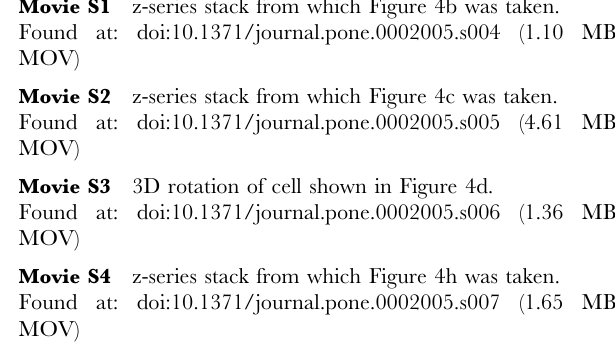
Figure S1 STOP2 confers conditional expression. (a) Epi- fluorescence image of a Pv-cre mouse injected with an AAV vector containing the short Neo-2xpA STOP cassette (LS2L) followed by the human RenillaGFP gene (AAV-LS2L-hrGFP, gift of C. Saper). (b–c) Confocal images of a wildtype control mouse co-injected with AAV-LS2L-hrGFP (b) and a generic AAV-RFP (c), at a 3:1 ratio. (d) Co-localization (white arrowheads) of GFP and parvalbumin (PV) in neocortical basket interneurons in neocortex of a Pv-cre mouse injected with AAV-LS2L-hrGFP; scale bar, 20 microns. Far right, high resolution image of basket cell axons with ‘‘basket-like’’ terminal branches and boutons (yellow arrowheads) around pyramidal cell somata (labeled with NeuN immunofluorescence) characteristic to PV + interneurons; scale bar, 5 microns. Figure S2 Low-level GFP expression in Pv-cre::Z/EG mouse. Epi-fluorescent image of young adult Pv-cre::Z/EG mouse using a 1 sec exposure time (13.3-times longer than that used in Fig. 2a) and a compressed look-up table. Cells (arrowheads) were not visible using the same acquisition parameters as in Fig. 2a. Neither axon nor dendritic branches were readily visible, though occasionally a dendritic branch trunk close to the soma was noted (arrow). Scale bar, 100 microns. Figure S3 60 days post-injection. Image of young adult Pv-cre mouse injected with AAV-LS1L-GFP using same parameters and look-up table as in Figure 2a; scale bar, 100